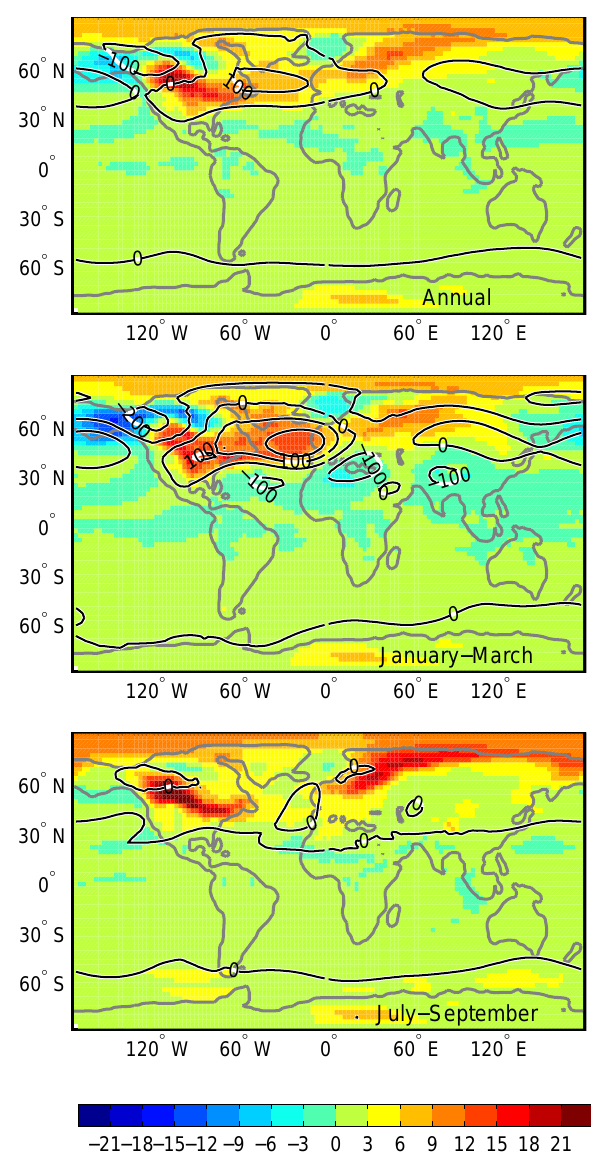
Fig. 6. Difference between GS12 and LGM T 2m (shading) and geopotential height at the 300-hPa surface (isolines) for annual mean (top panel), JFM (middle panel), and JAS (bottom panel). Isolines for geopotential height are displayed for every 100 geopo- tential meter. The coastline is defined at 20% of the land